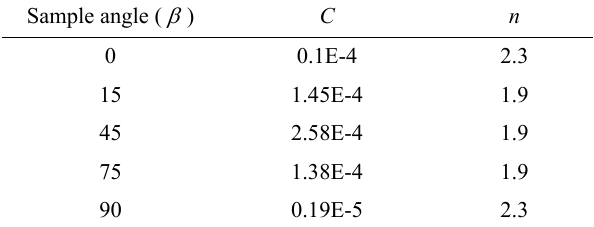
Table 4 Constant and the power in the function of the erosion versus the